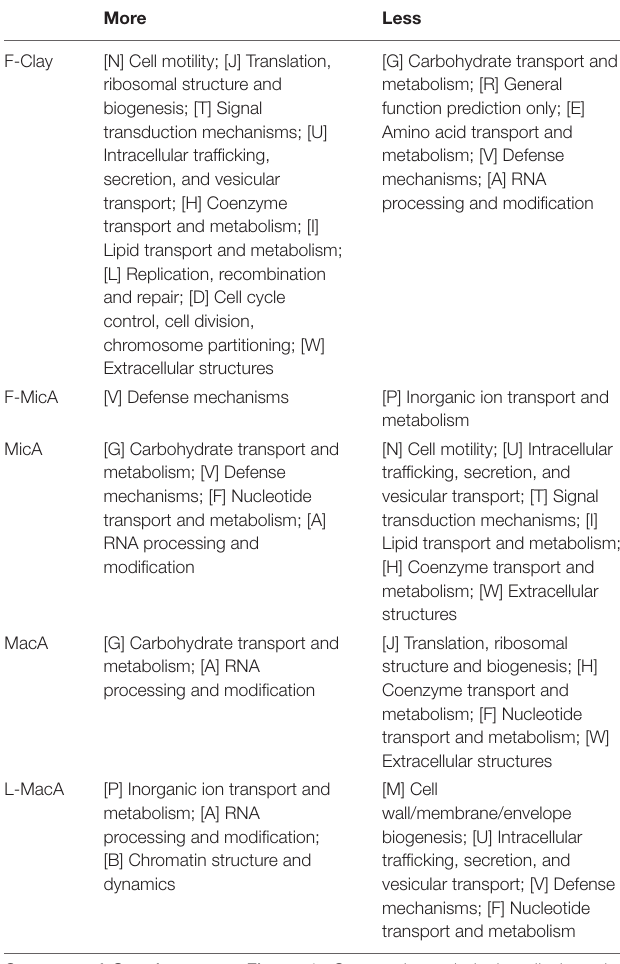
TABLE 4 | Summary of the PICRUSt results of 16S rDNA at COG